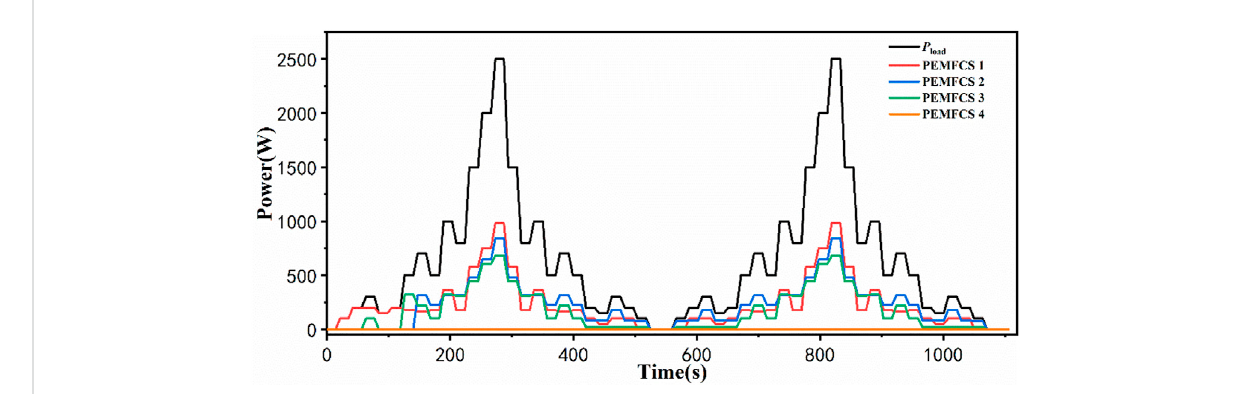
FIGURE 10 Stack No.4 with fails at the MFC system start.